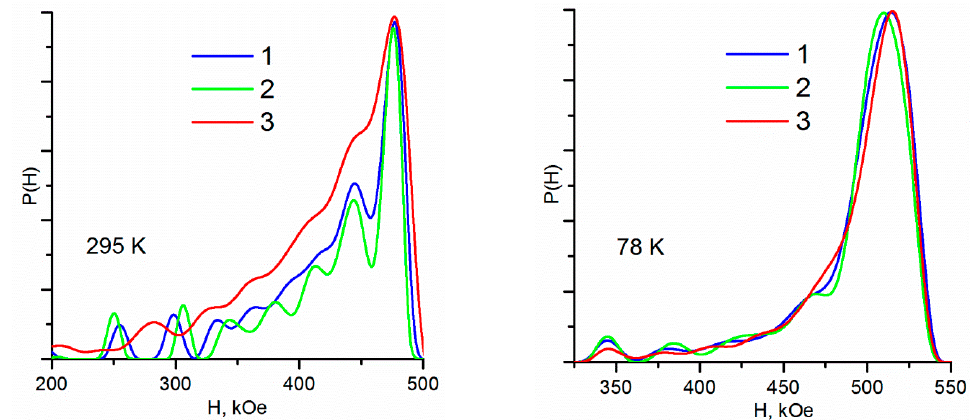
Figure 3. Probability functions of the distribution of magnetic fields at different sample tempera ‐ tures: 1— М , 2— МА , 3— Маох . Table 3. Results of the description of the Mössbauer spectra of the samples Fe 3 ‐δ O 4 using the dis ‐ tribution function of magnetic fields (P(H)) and within the framework of the multilevel super ‐ paramagnetic relaxation (MSSPR) model.